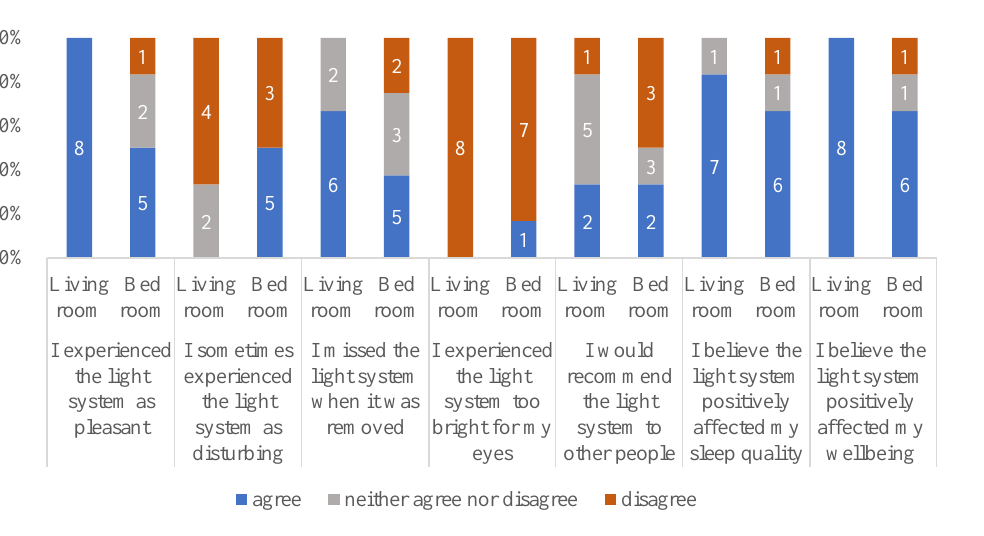
Figure 4. Responses to a short follow-up survey regarding the experiences of the participants with respect to the living room and bedroom.